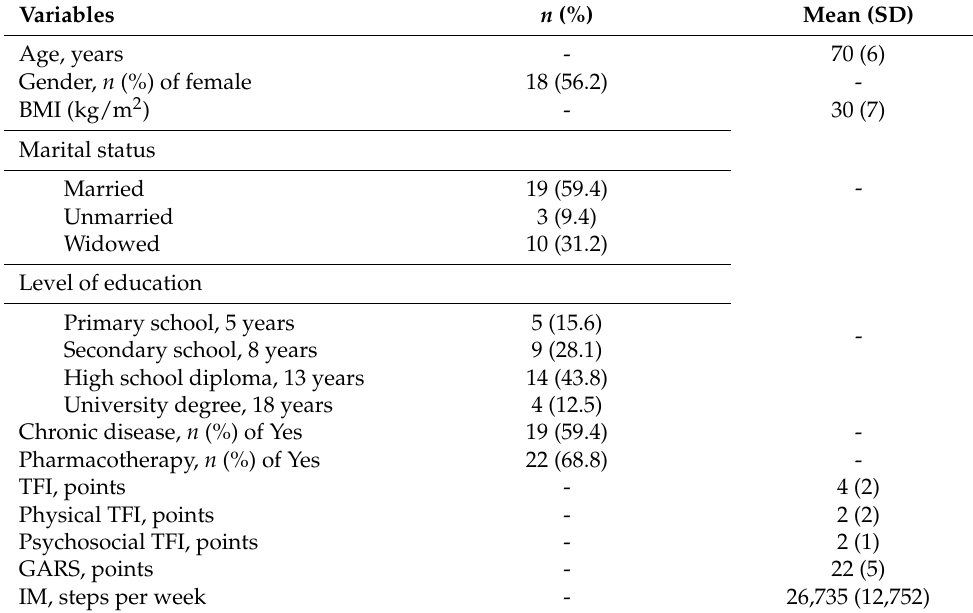
Table 1. Sociodemographic data of the sample.